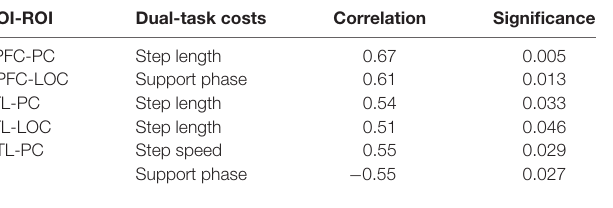
TABLE 5 | The analysis of dual-task costs and ROI of EG during Task 2. ROI-ROI